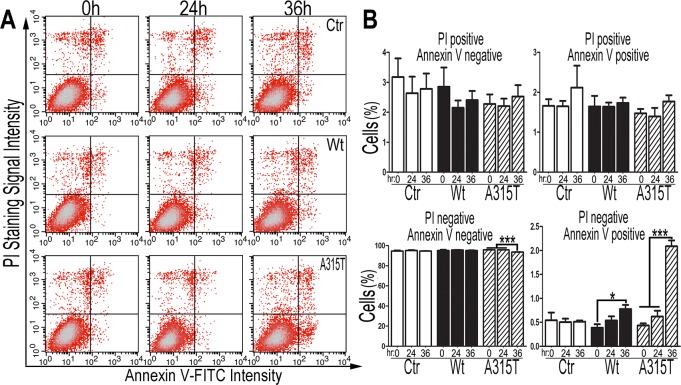
Expression of the Wt or A315T-mutant TDP-43 induces cell death in inducible stable cells.(A) FACS analyses of cells following staining using an Annexin V-FITC/PI kit to quantify cell death in HEK293 cells following induction of TDP-43 expression. (B) Quantification of the percentage of different cell populations at different time points. At 36 hr post-Tet induction, the expression of either Wt or A315T-mutant TDP-43 protein induced apoptosis (Annexin V positive and PI negative) but not necroptosis (Annexin V negative and PI positive) or late apoptosis (Annexin V positive and PI positive). The data were analyzed using a one-way ANOVA with Bonferroni post hoc test (representing 4 independent experiments; *: P<0.05; **: P<0.01; ***: P<0.001).